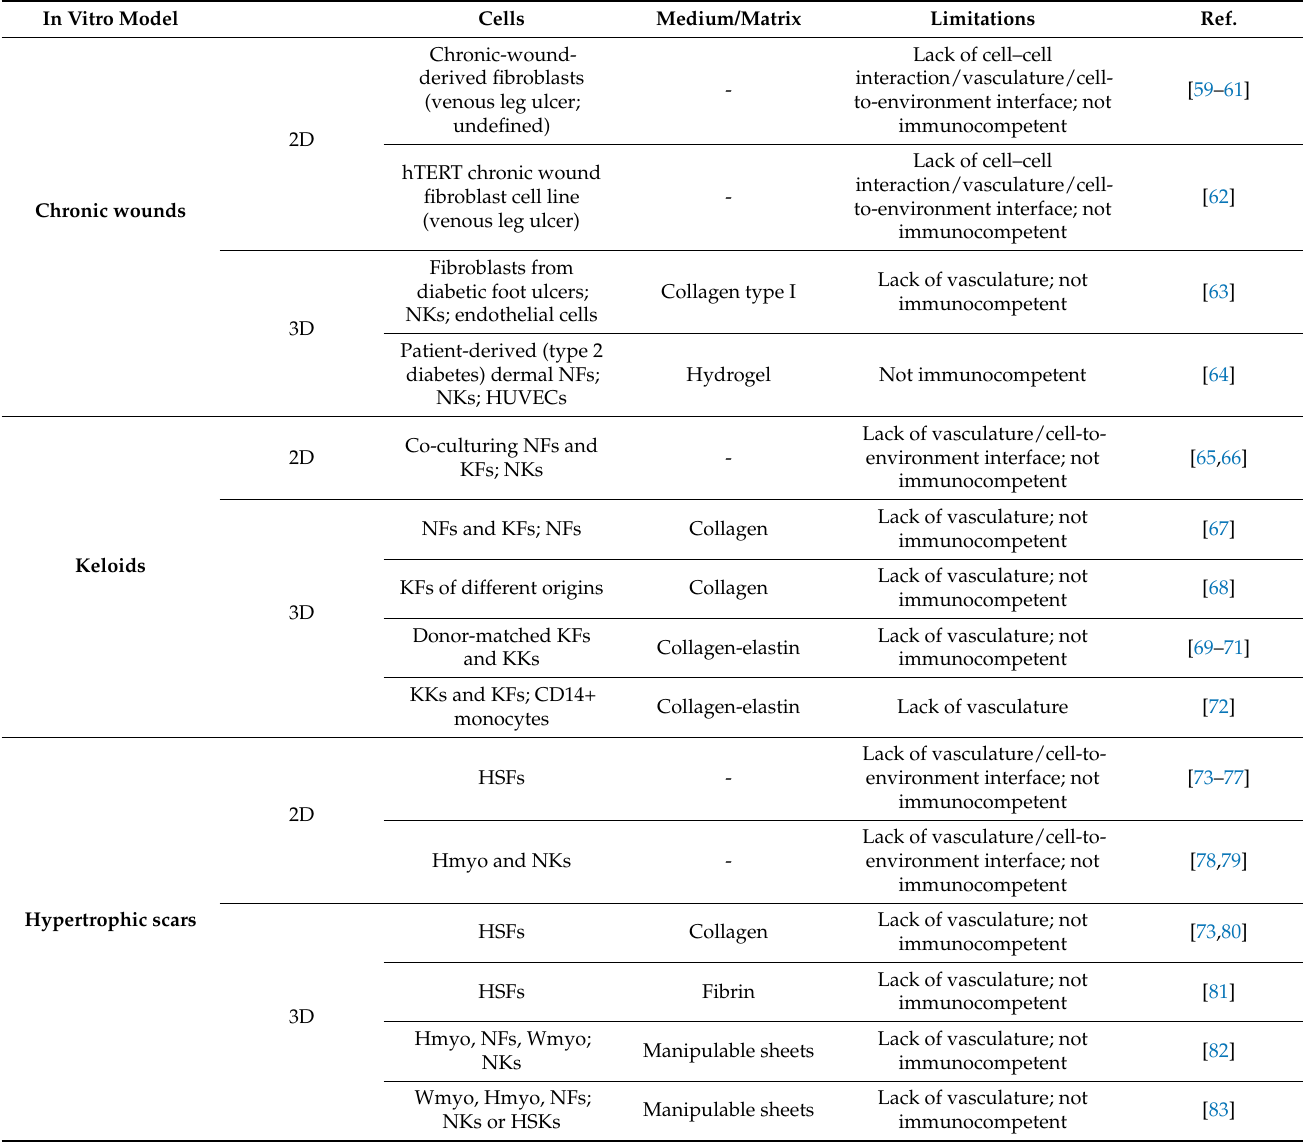
Table 1. Summary of in vitro models for wound healing